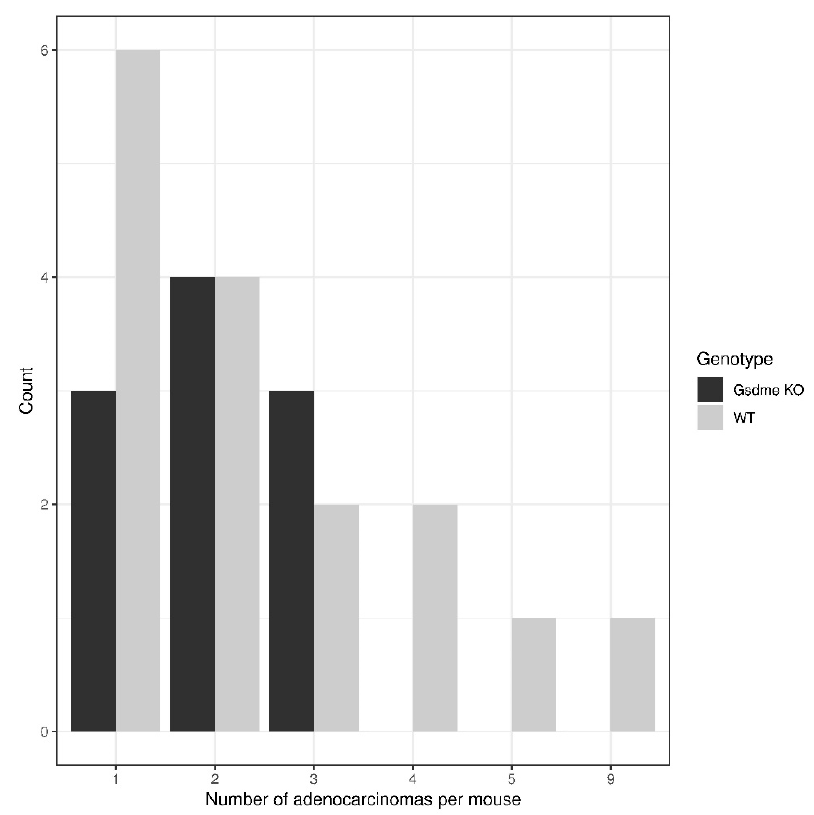
Figure 7. Distribution of the number of adenocarcinomas per mouse in Apc 1638N /+ Gsdme KO and Apc 1638N /+ Gsdme WT mice. There were 10 out of 13 (76.9%) Apc 1638N /+ Gsdme KO and 16 out of 24 (66.7%) Apc 1638N /+ Gsdme WT mice with one or more adenocarcinomas in the small intestine, with a median of two adenocarcinomas / mouse (range: 1–3) for the Gsdme KO mice, and a median of two adenocarcinomas / mouse (range: 1–9) for the WT mice.